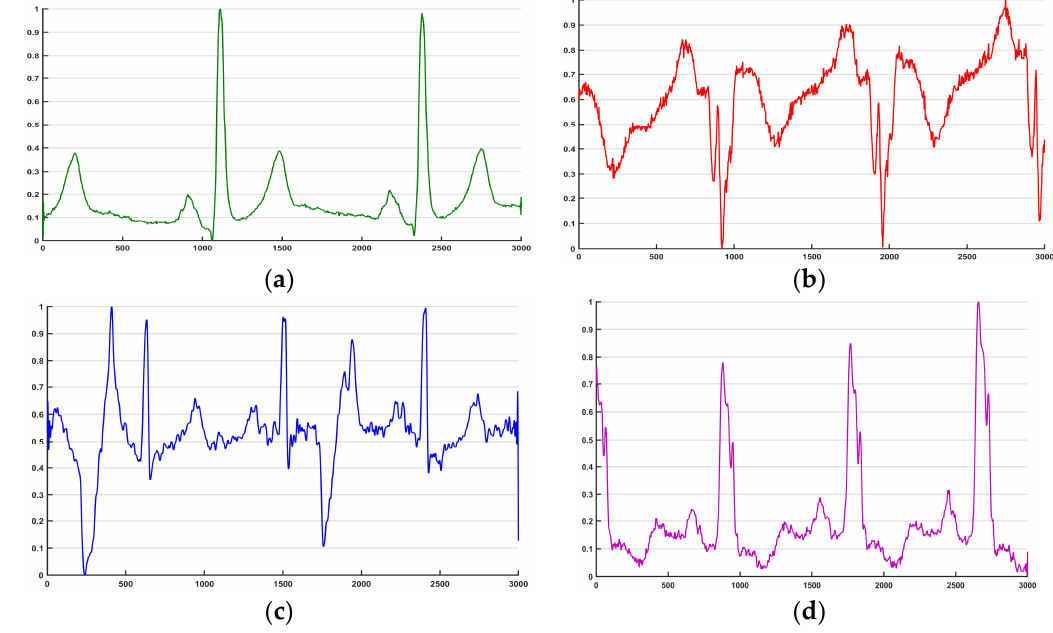
Figure 2. The waveform of one ECG segment. ( a ) normal; ( b ) MI; ( c ) CAD; ( d ) CHF. Table 4. The implementation flow of the ASFS.